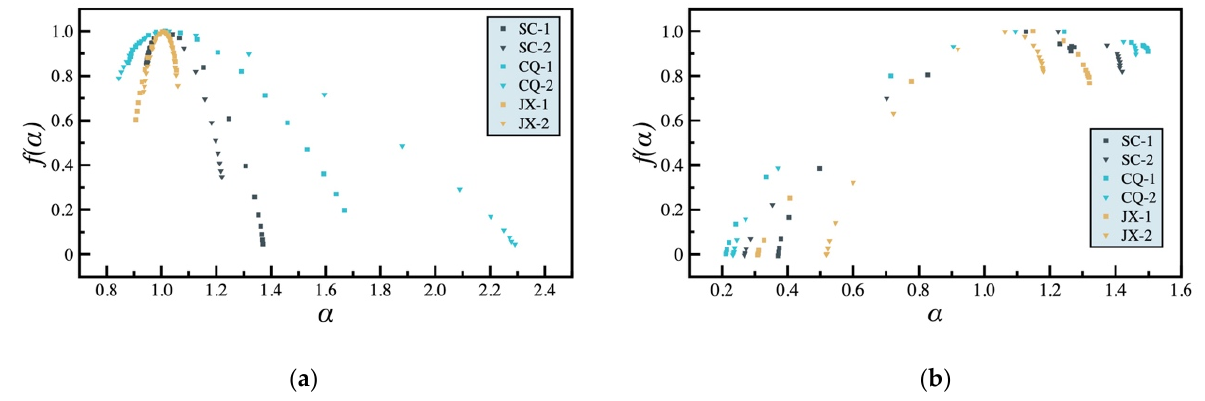
Figure 5. Multifractal spectra of shale pores: ( a ) organic pores, ( b ) inorganic pores.